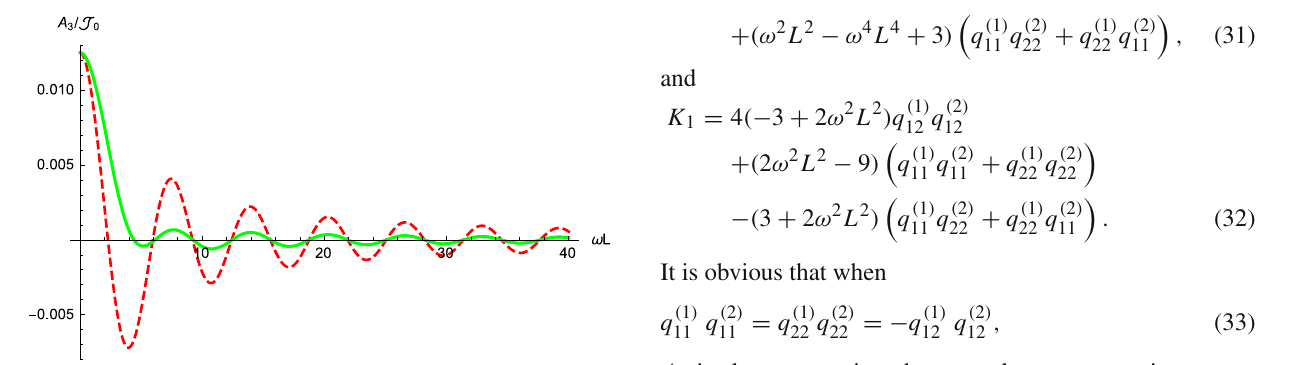
(α) = − q (α) = | q | and q (α) = − q (α) = 11 22 11 33